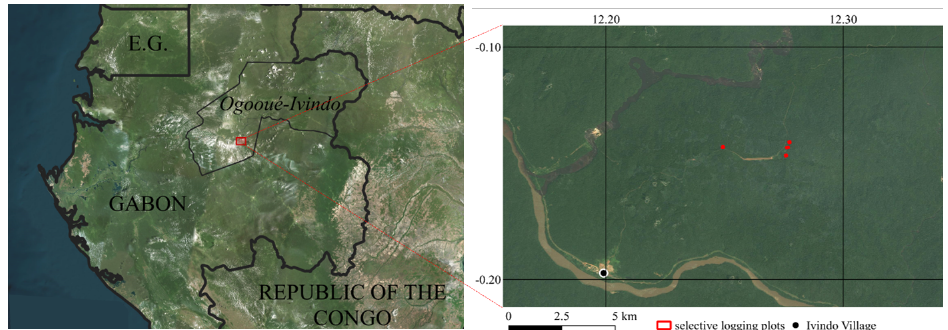
Figure 1. Location of the study site at Ivindo, Gabon. Inset shows grid coordinates in decimal degrees, and indicates the location of the four selectively logged plots in relation to Ivindo village, which is also a base for logging operations in the region. (left, Earthstar Geographics, SIO, © 2021 TomTom; right, © 2021 Landsat/Copernicus, Maxar